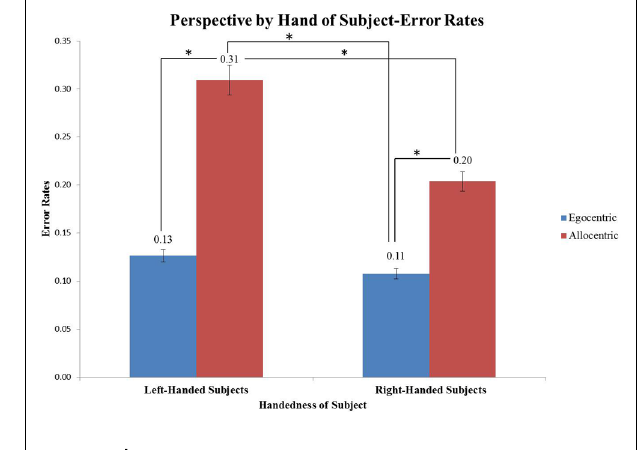
FIGURE 6 | Graph depicts an interaction effect between perspective and hand of subject (* p < 0.05). Right-handed subjects looking at images in the egocentric perspective were more accurate at the task when compared to allocentric images (* p = 0.019). Overall, left-handed subjects looking at images in an allocentric perspective were significantly worse compared to all other conditions (* p <